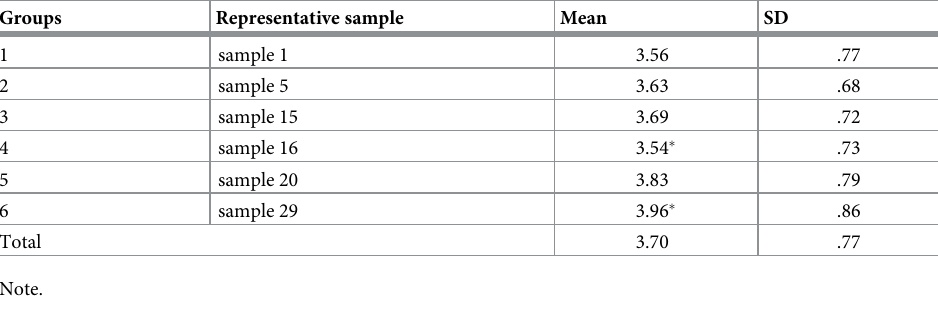
Table 7. Test results of